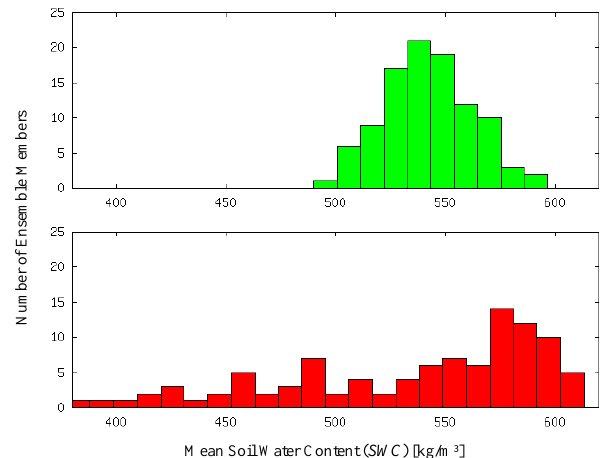
Fig. 12. TERRA-ML’s soil column is 2.43m deep. The soil-water content (SWC) of each grid cell depends on its soil depth and its soil moisture (Eq. 9). Distribution of initial mean SWC ( t =0) in the Große Enz catchment (90km 2 ) between the ensemble mem- bers. CONTROL mean SWC is 568kg/m 2 . The analysis at t =0 was obtained assimilating streamflow from the CONTROL model simulation from Pforzheim from t =0 to t =56h with a 0.5 hourly